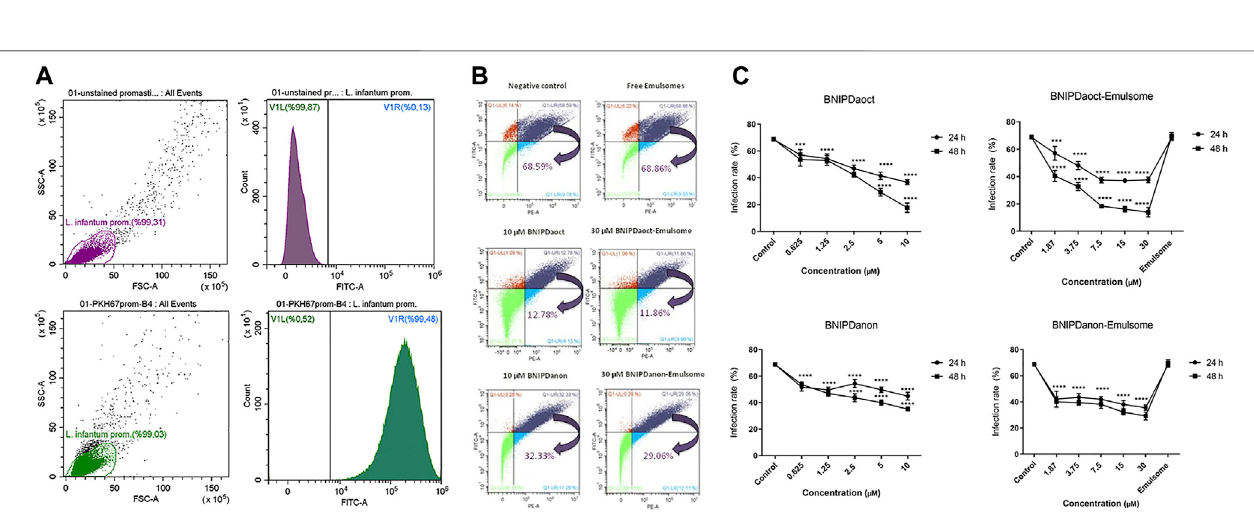
FIGURE 5 | Microscopy analysis of stained macrophage – promastigote co-culture (A) phase contrast and (B) fl uorescence microscopy images of PKH26-stained macrophages(red)infectedwithPKH67-stained L.infantum promastigotes(green).Themergedyellowcolordisplays Leishmania -infectedmacrophages(magni fi cation: × 63; size bars: 20 µm).